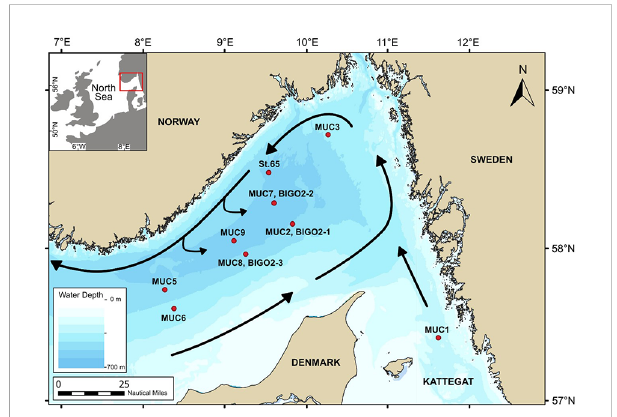
FIGURE 1 Study area and sampling sites of MUCs and BIGOs within the Skagerrak. Black arrows indicate the surface water